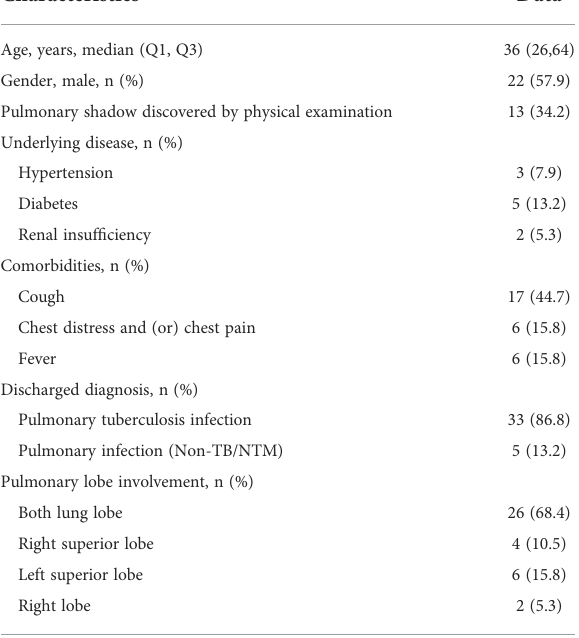
TABLE 3 Characteristics of 38 patients used for clinical